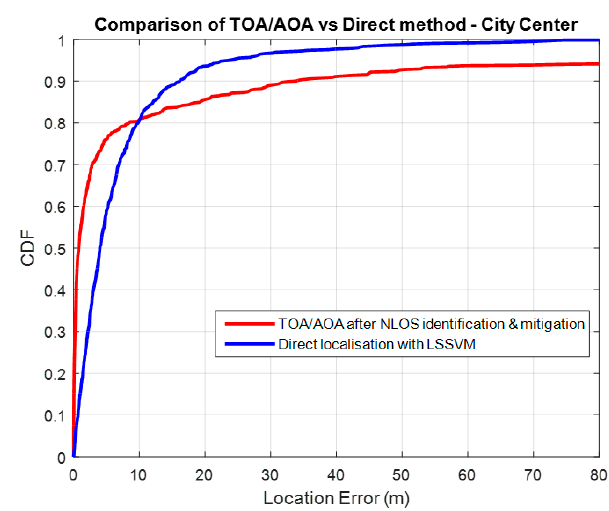
Figure 8. Direct method vs. TOA/AOA.